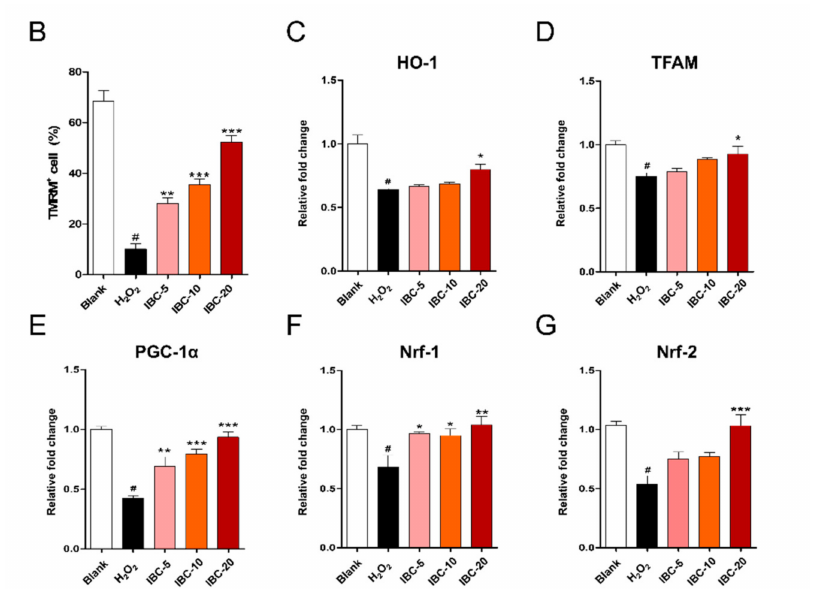
Figure 6. Effect of IBC extract on mitochondrial biogenesis following H 2 O 2 -induced oxidative stress injury in rat primary cortical neurons. ( A ) Representative images of TMRM stained neurons in each group. White scale bar = 50 µ m, Red scale bar = 15 µ m. ( B ) Quantification of the relative percentage of the total number of TMRM+ cells in cortical neurons (n = 6). ( C – G ) Expression of genes related to mitochondrial biogenesis following H 2 O 2 treatment and the application of varying doses of IBC for 24 h (n = 6); ( C ) HO-1 , ( D ) TFAM , ( E ) PGC-1 α , ( F ) Nrf-1 and ( G ) Nrf-2 . Data are expressed as the means ± SEM. Significant differences indicated as # p < 0.001 compared vs. the blank group, * p < 0.05, ** p < 0.01 and *** p < 0.001 vs. the H 2 O 2 group were analyzed via one-way ANOVA with Tukey’s post hoc